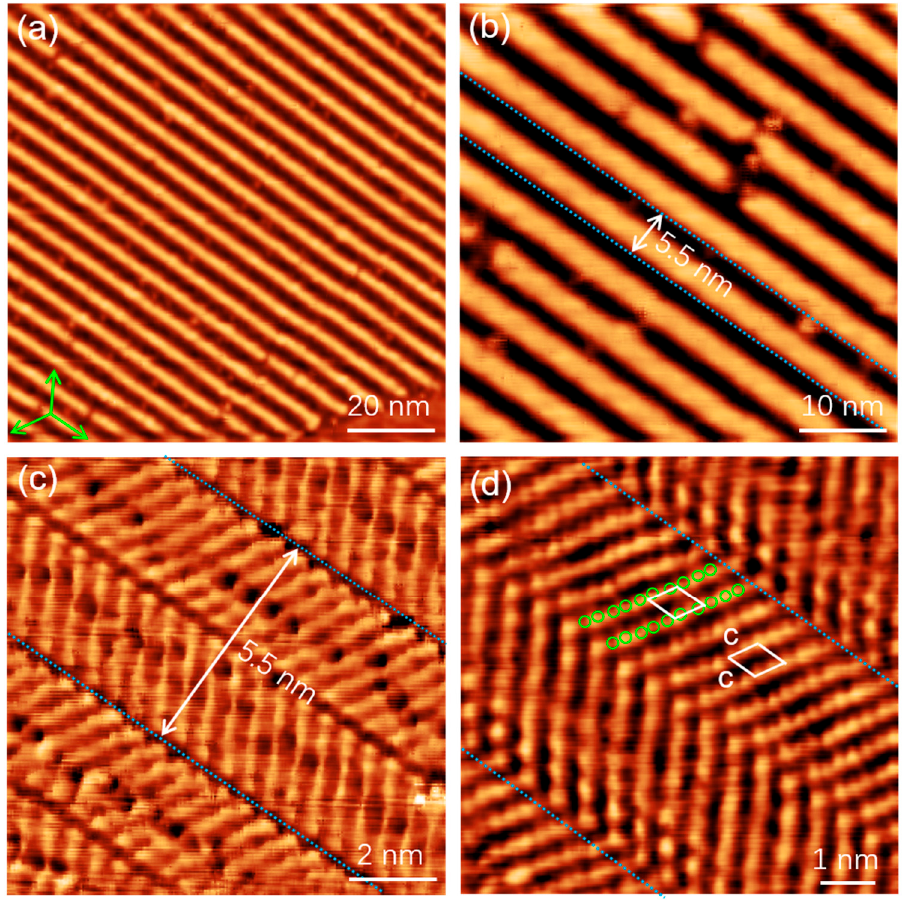
Figure 4. Pure domain of the Cd nanostripes on top of the Cd(0001) surface. ( a ) Periodic arrays of Cd nanostripes of Cd, 3.6 V, 20 pA. ( b ) Zoom-in image of the Cd nanostripes, 3.0 V, 20 pA. ( c ) Parallel segments of Cd atomic chains appeared in the Cd nanostripes, 0.16 V, 20 pA. ( d ) High-resolution STM image of the Cd atom chains with a 2 × 2 reconstruction, 0.1 V, 20 pA.